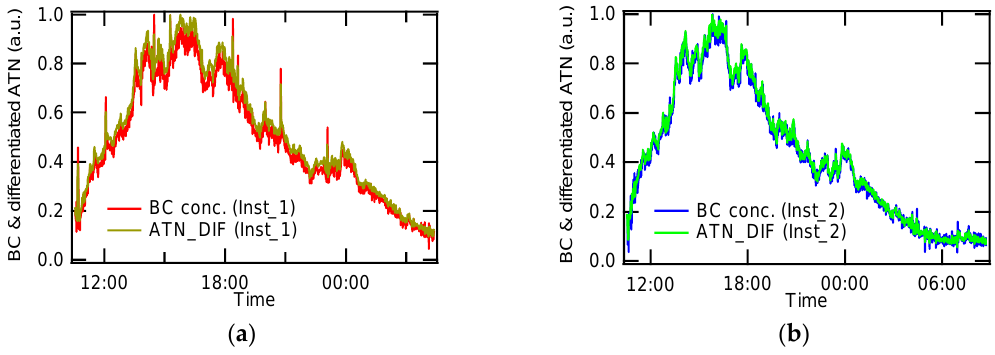
Figure 4. Comparison of the black carbon (BC) concentration and normalized numerical differentiation of ATN. ( a ) Inst_1, ( b ) Inst_2.